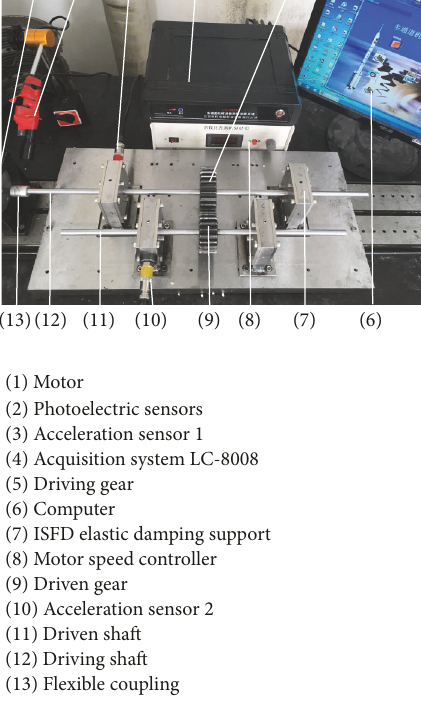
Figure 7: Test apparatus.